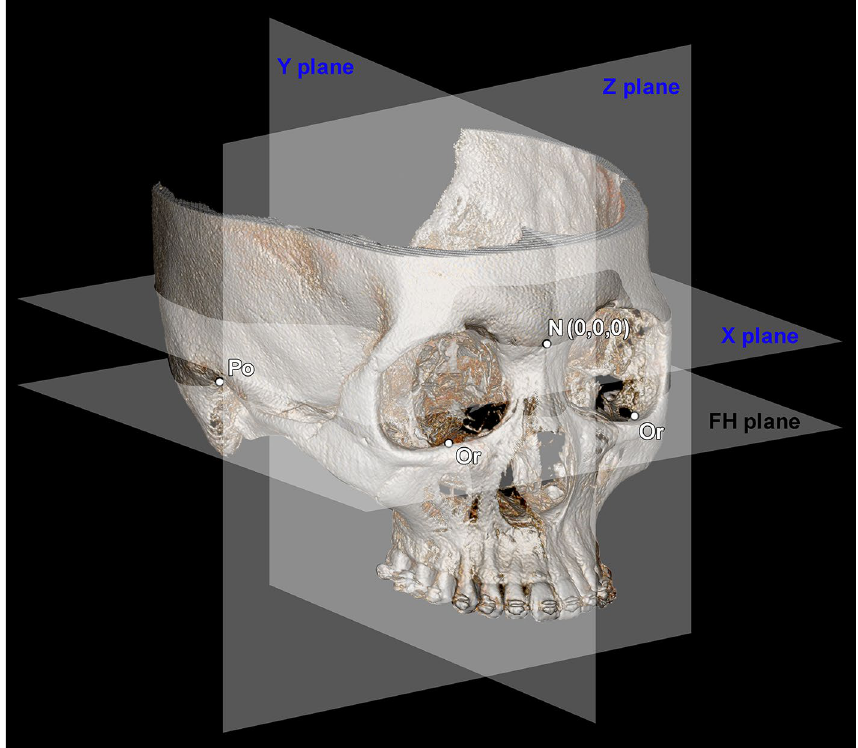
Figure 2. The DICOM data from CBCT were converted to stereolithography format, oriented, and reconstructed following reference planes. The X plane is the plane passing the nasion (N), which is parallel to the Frankfort horizontal (FH) plane passing through the left and right orbitales (Or) and the right porion (Po). The Y plane is the plane passing through the N and basion, while perpendicular to the X plane, and the Z plane is perpendicular to the X- and Y-planes, setting the plane through the N (0, 0,